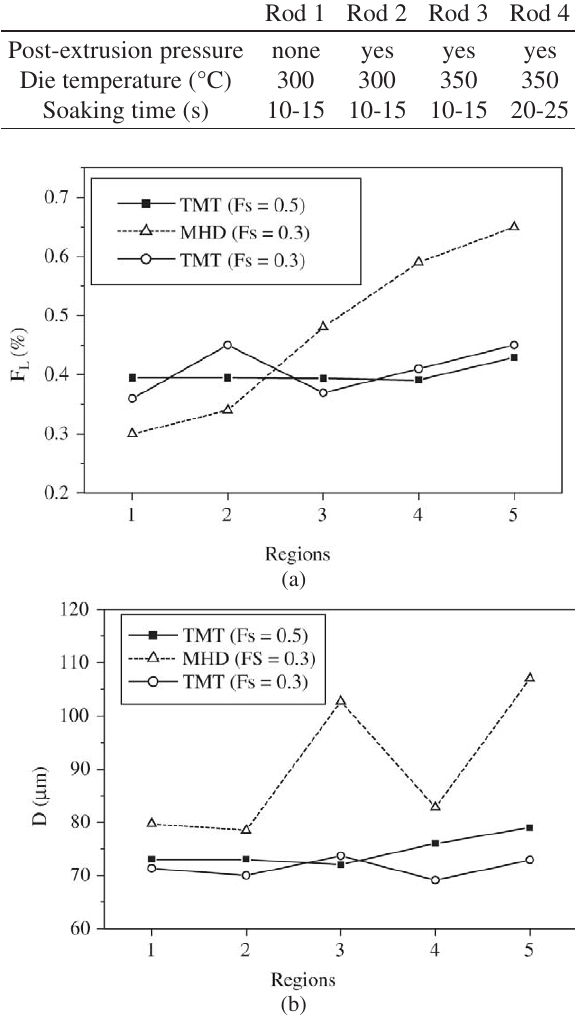
Figure 8. Spatial distribution within the rods of a) liquid fraction; b) particle size. Thixoextruded rods originated from TMT and from MHD conditioned A356 alloy, with f s = 0.5.